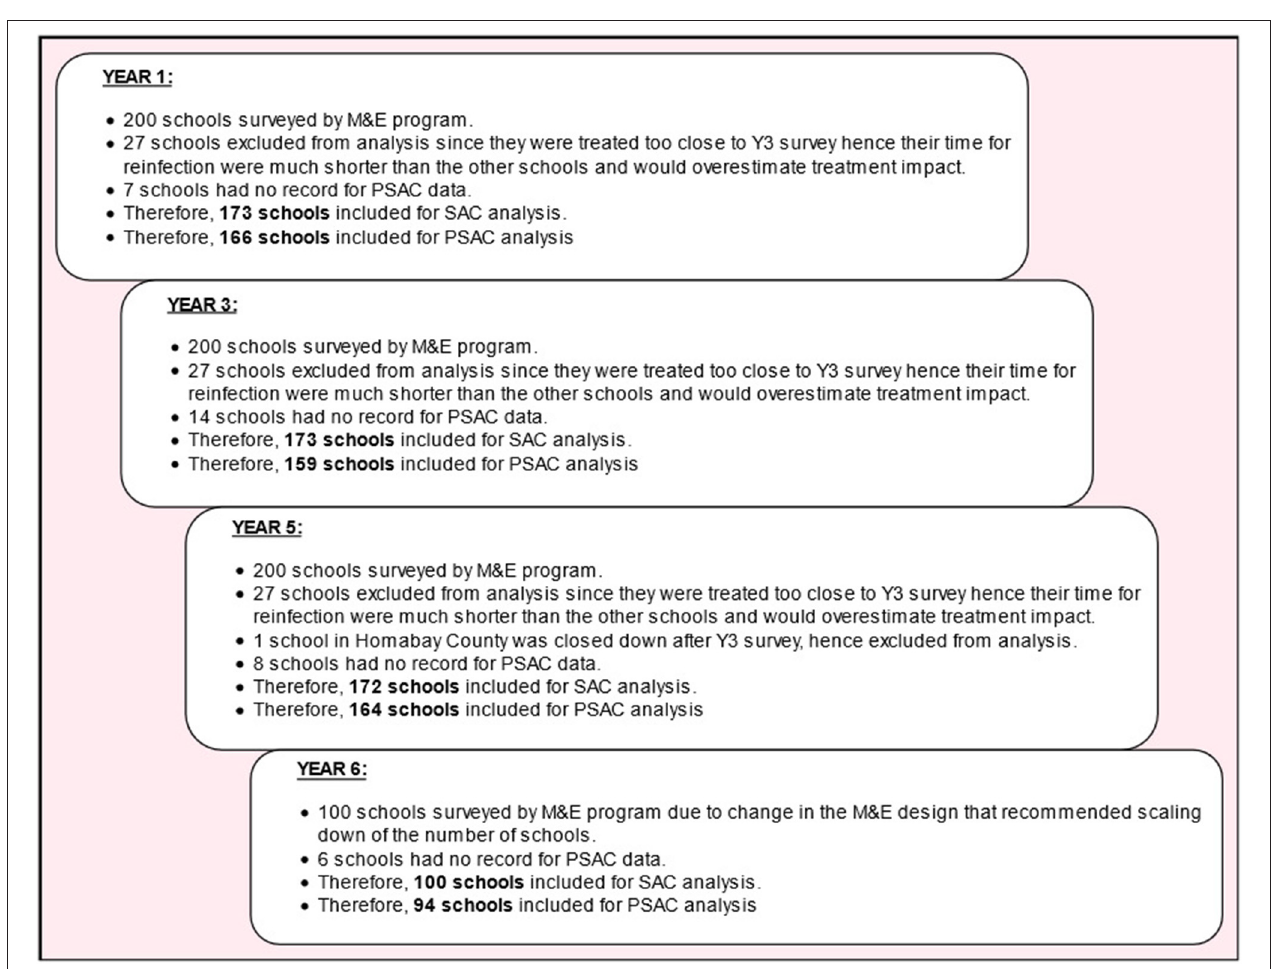
FIGURE 1 | Schema illustrating the number of schools extracted from the NSBDP’s M&E database and the number of schools included in this analysis.